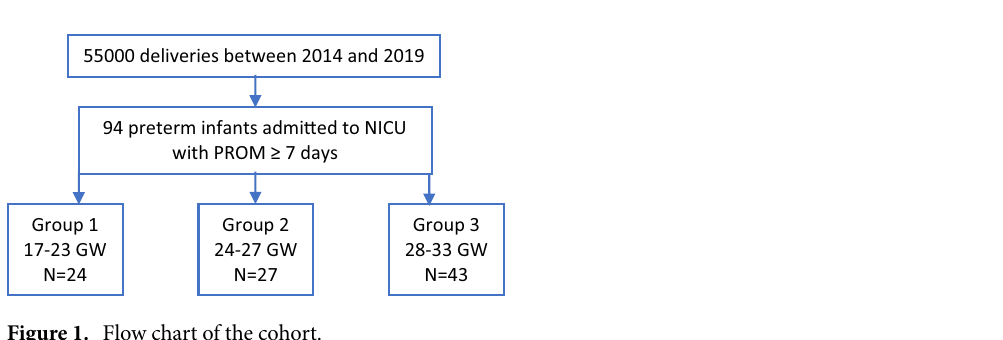
Figure 1. Flow chart of the